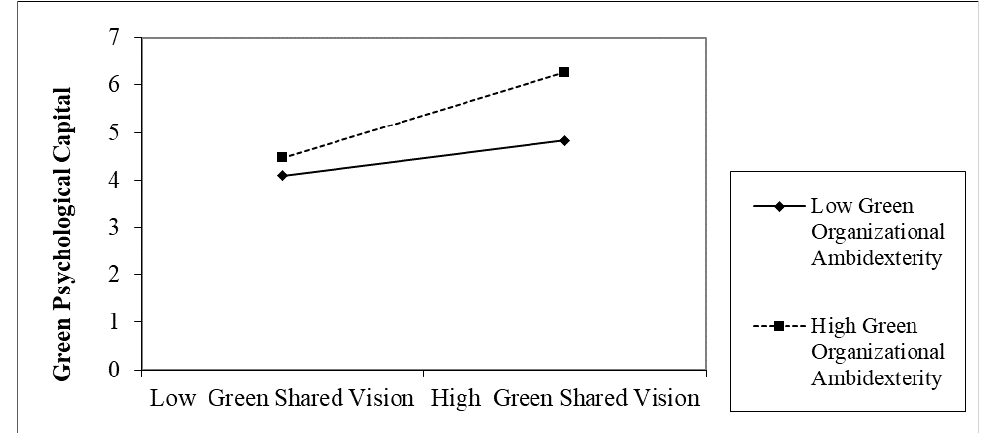
Figure 2. Moderating role of green organizational ambidexterity.